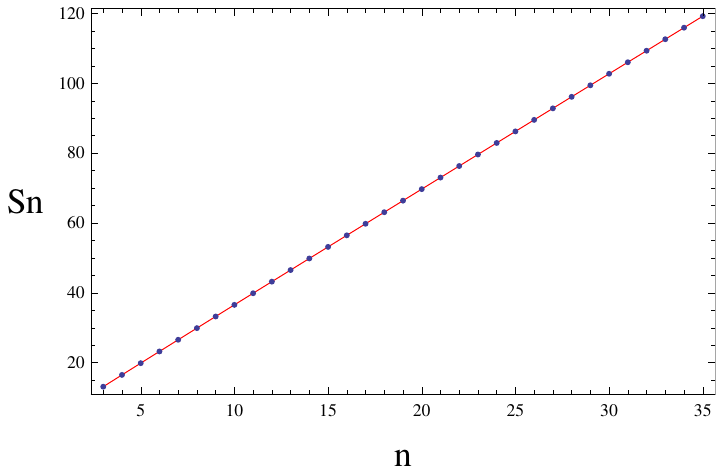
Figure 7 . The entanglement entropy of gauge (cid:12)elds with A ^ A .